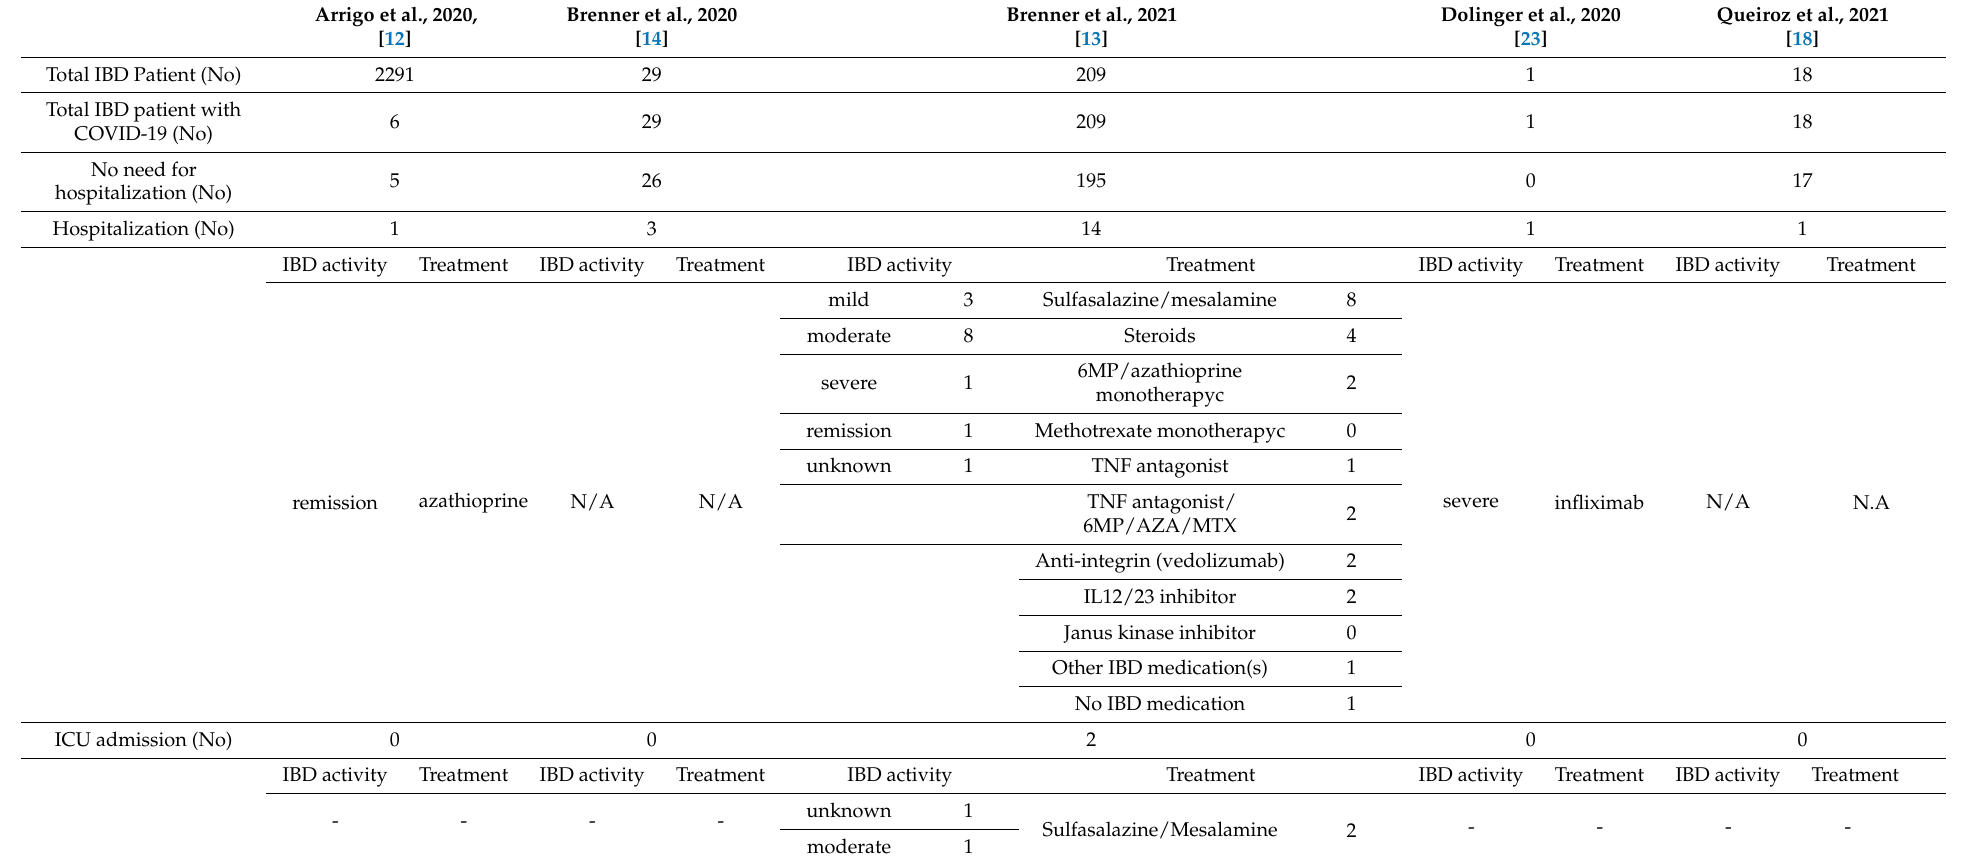
Table 2. Studies that provide data regarding patients with PIBD hospitalized due to